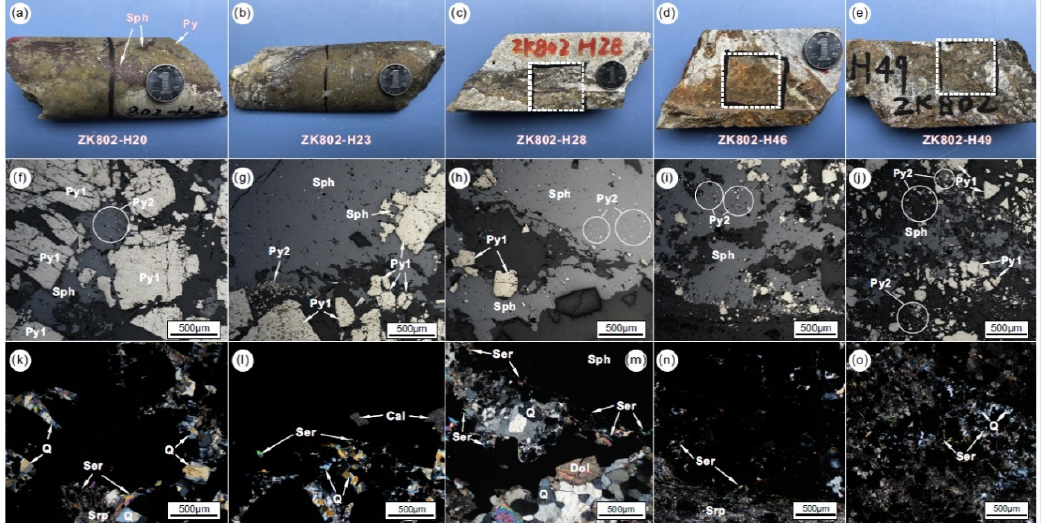
Figure 4. Photographs and photomicrographs showing the ore rocks from drilling ZK801 of the Liushuping Au–Zn deposit: ( a , b ) massive structure ore rocks are dominated by coarse-grained pyrites that interspersed with irregular vein-like sphalerite; ( c ) vein structure ore rock; ( d , e ) disseminated structure ore rocks, and ferritization; ( f ) coarse-grained pyrites in the massive ore rock; ( g ) coarse-grained pyrites replaced by sphalerite and clustered fine-grained pyrite (Py2) in the massive ore rock; ( h ) the vein-like ores are dominated by sphalerite and clustered fine-grained pyrite (Py2); ( i , j ) disseminated ores are dominated by sphalerite and clustered fine ‐ grained pyrite (Py2), coarse ‐ grained pyrites are severely fragmented; ( k ) coexistence of quartz, sericite, calcite, and sphalerite to replace coarse ‐ grained pyrites (Py1), the same position as photo ( f ) under orthogonal polarization; ( l ) coexistence of quartz, sericite, calcite, and sphalerite to replace coarse ‐ grained pyrites (Py1), the same position as photo ( g ) under orthogonal polarization; ( m ) coexistence of quartz, sericite, dolomite, and sphalerite to replace coarse ‐ grained pyrites (Py1), the same position as photo ( h ) under orthogonal polarization; ( n ) coexistence of quartz, sericite, serpentine, and sphalerite, the same position as photo ( i ) under orthogonal polarization; ( o ) coexistence of quartz, sericite, serpentine, carbonates, and sphalerite in the disseminated ore, the same position as photo ( j ) under orthogonal polarization. Abbreviations: Cal—Calcite; Dol—Dolomite; Py—pyrite; Q—quartz; Ser—sericite; Srp—Serpentine; Sph—sphalerite.